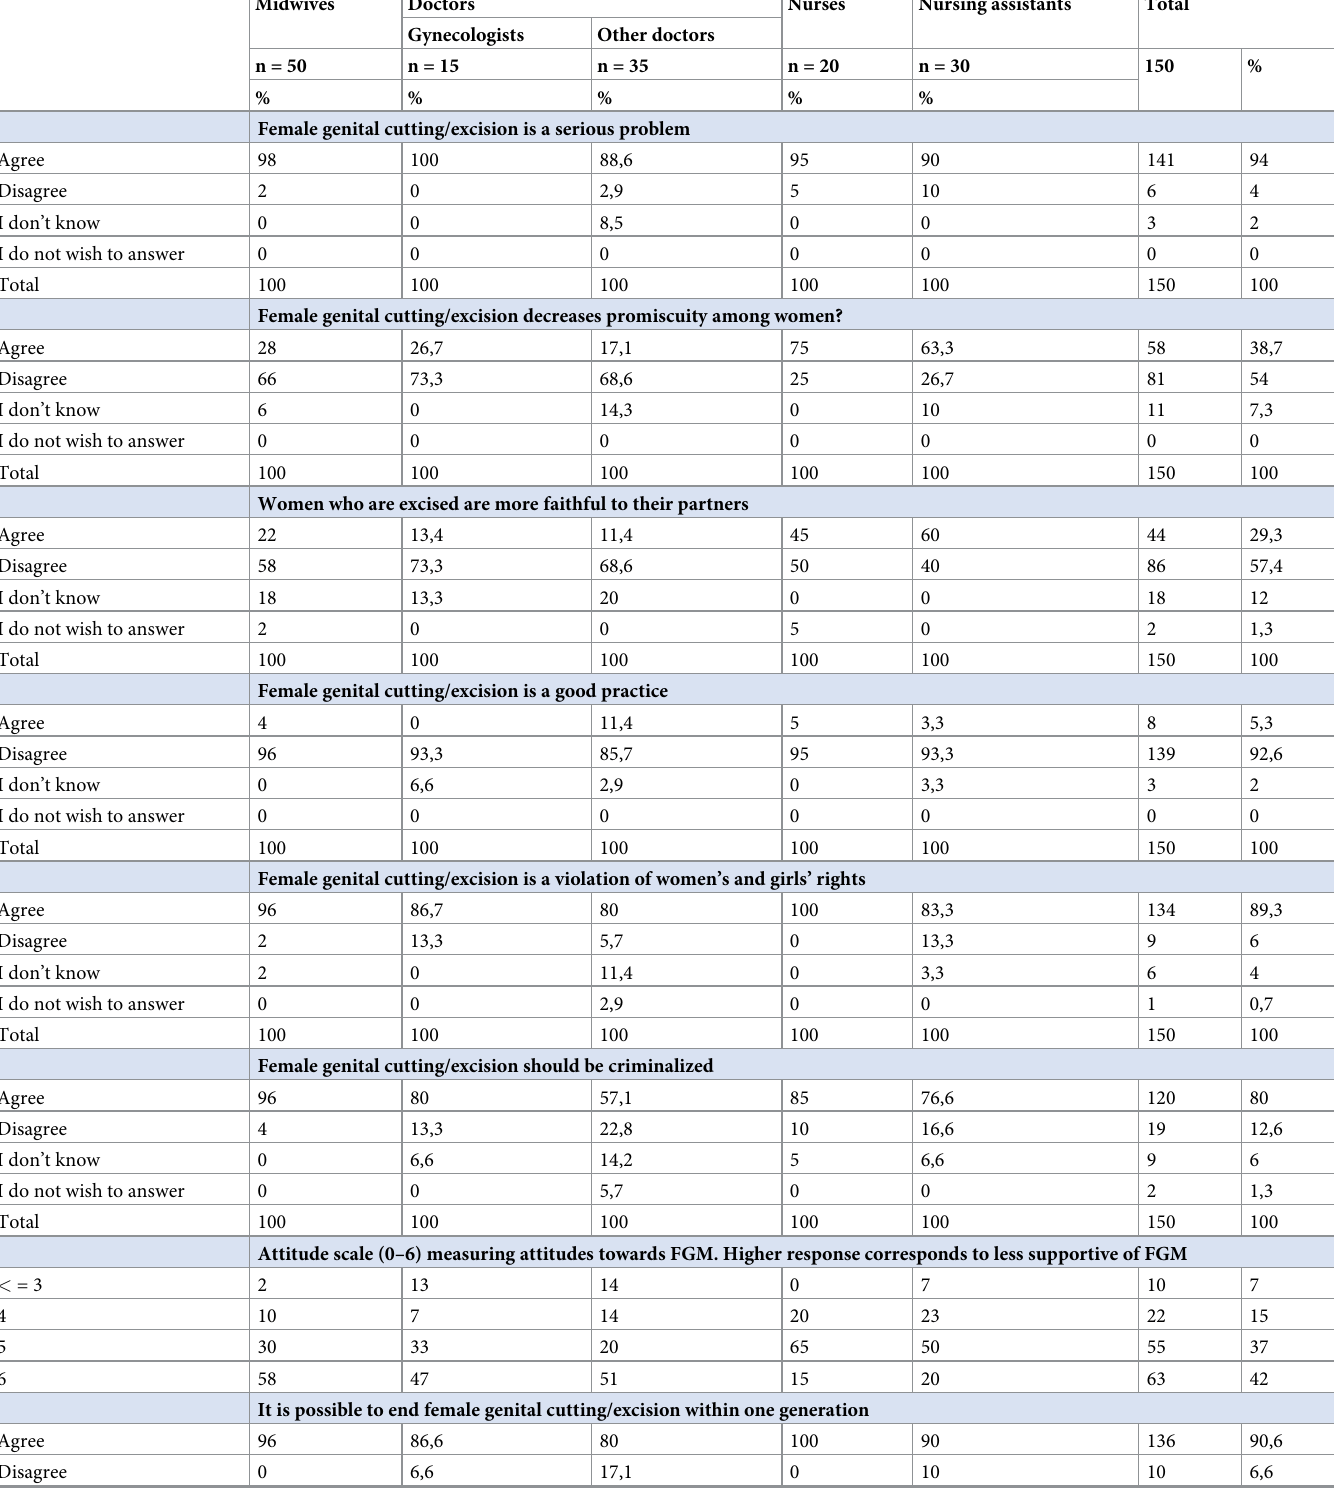
Table 4. Social, legal and ethical aspects of attitudes about FGM based on questionnaire